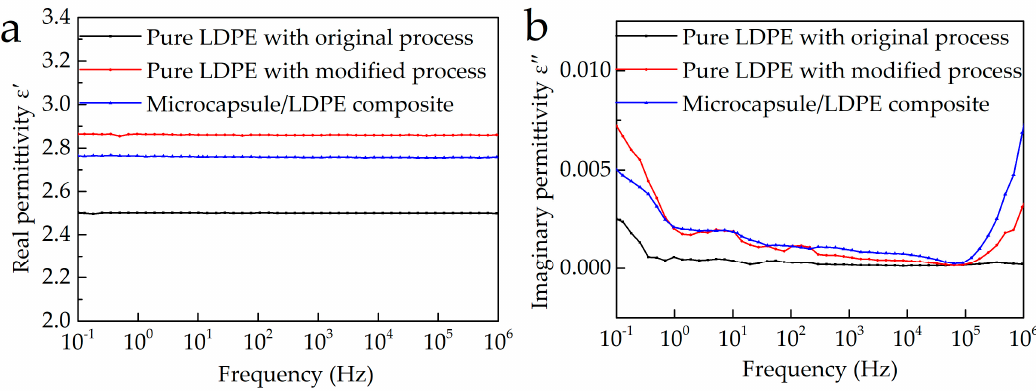
Figure 9. Dielectric properties of samples. ( a ) Real part of permittivity. ( b ) Imaginary part of permittivity.